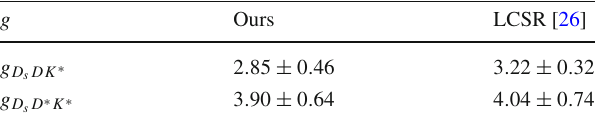
Table 4 Values of the strong coupling constant using the 3PSR (ours) and LCSR approaches